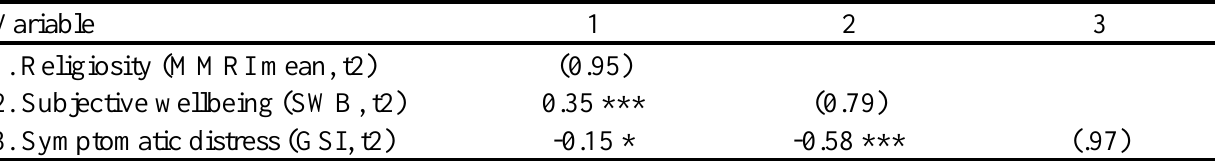
Table 4. Post-test correlations between religiosity, well-being and